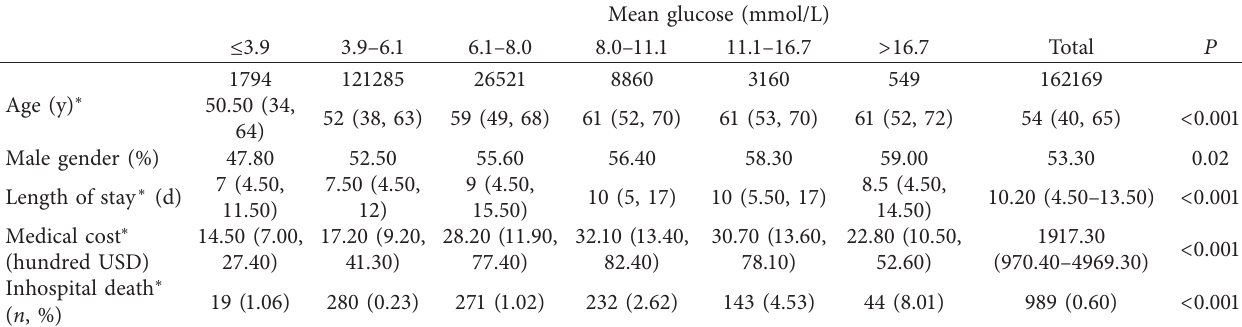
Table 2: Association of mean glucose with in hospital death proportion, medical cost, and length of stay.